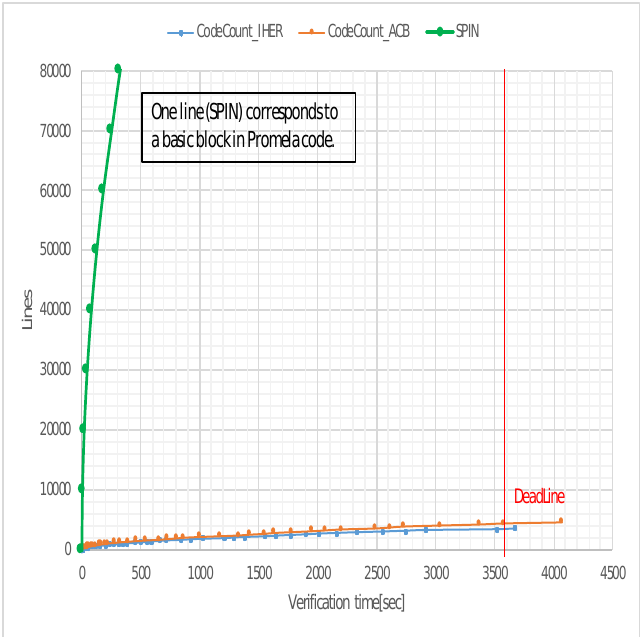
Figure 14. Comparison of SPIN and proposed